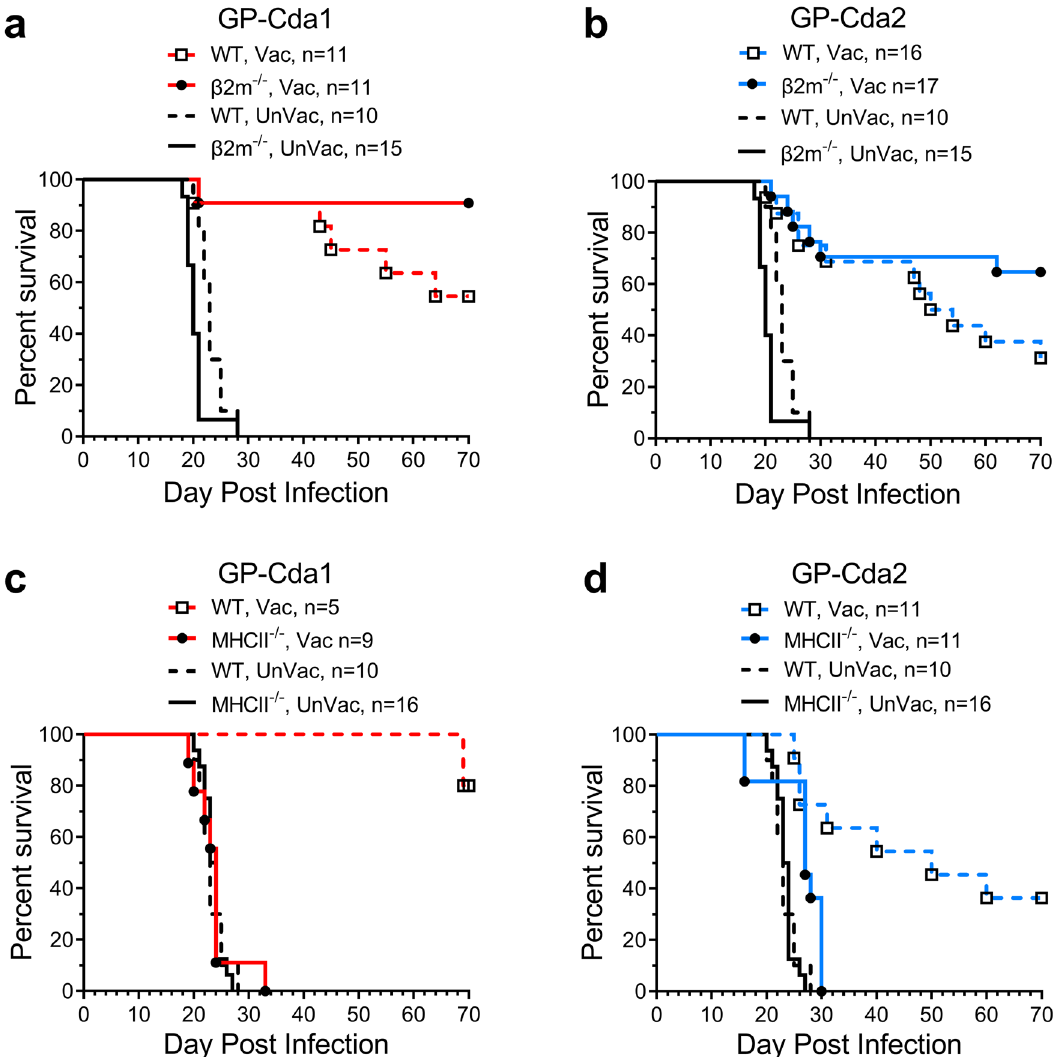
Fig. 2 Contribution of CD8 + and CD4 + T cells to protection by GP-Cda1 or GP-Cda2. Top panel: Wild-type (WT) C57BL/6 mice and CD8 + T cell-de fi cient ( β 2m) mice on the C57BL/6 background received a prime and two biweekly boosts with GP-Cda1 ( a ) or GP-Cda2 ( b ). Two weeks after the last boost, mice were challenged with C. neoformans and followed 70 days for survival. Vac vaccinated with GP-Cda1 or GP-Cda2. UnVac unvaccinated. n denotes the number of mice in the experimental group. Bottom panel: Same as the top panel except for CD4 + T cell-de fi cient (MHCII − / − ) mice were used ( c , d ). Note the same survival curves are shown for unvaccinated mice in Fig. 2a, b as well as in Fig. 2c, d. P < 0.005 when comparing WT Vac vs WT UnVac ( a – d ), mutant Vac vs mutant UnVac ( a , b , d ), and WT Vac vs mutant Vac ( c , d ) using Mantel – Cox log-rank Fig. 4a, injection of 200 µg of GK1.5 led to nearly complete depletion of blood CD4 + T cells for two weeks. Two strategies for CD4 + T cell depletion were conducted. In the fi rst, mice were